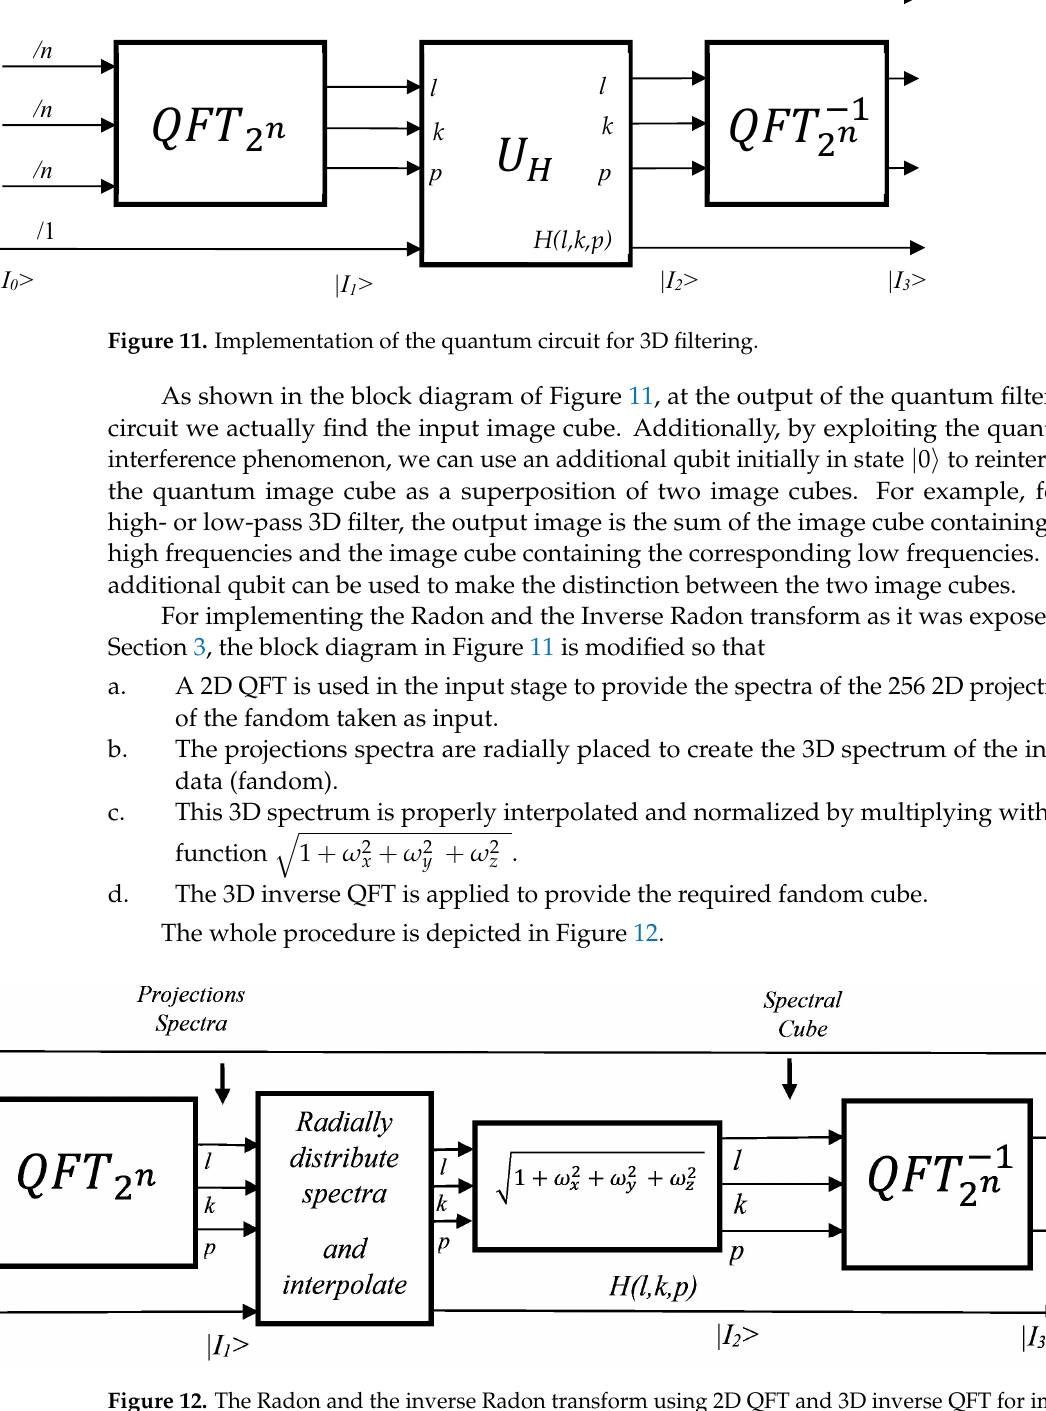
Figure 10. This is an example of 2 × 2 × 2 quantum cube with eight di ff erent colors. Three qubits are used to represent color information and three-pixel position information.